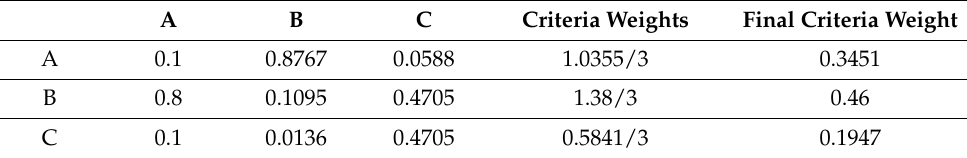
Table 5. Normalized Criteria Weight Matrix for Main Criteria (one expert). A B C Criteria Weights Final Criteria Weight